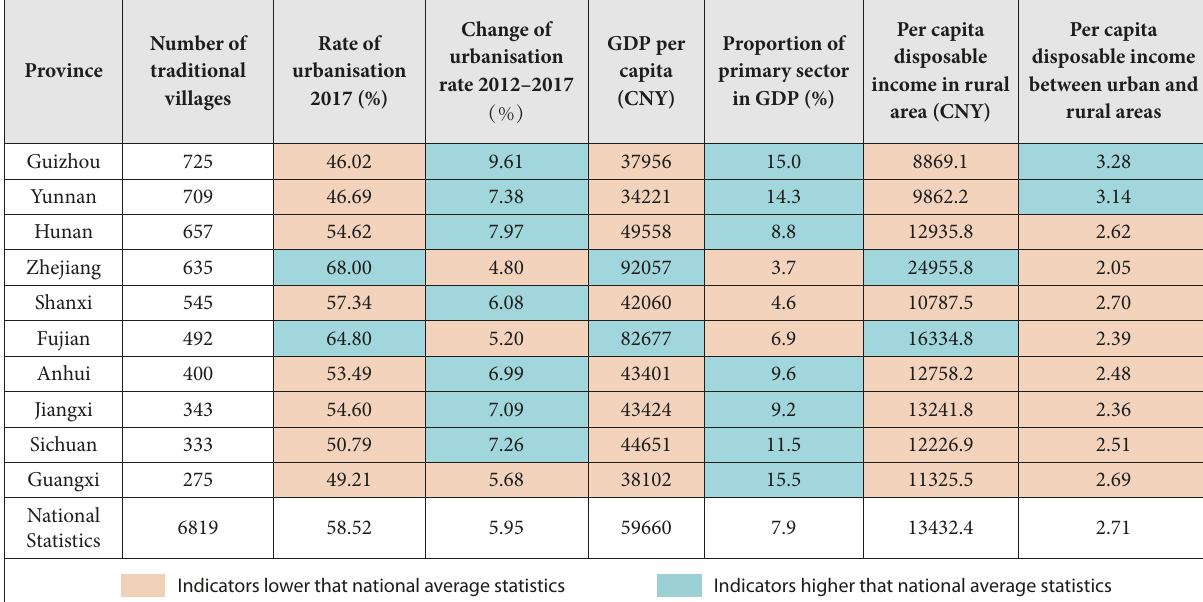
Indicators higher that national average statisticsIndicators lower that national average